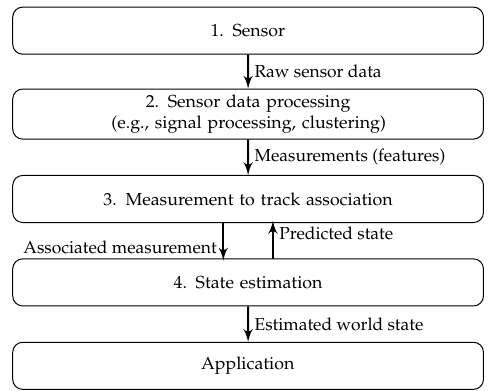
Figure 1. Traditional single sensor state estimation